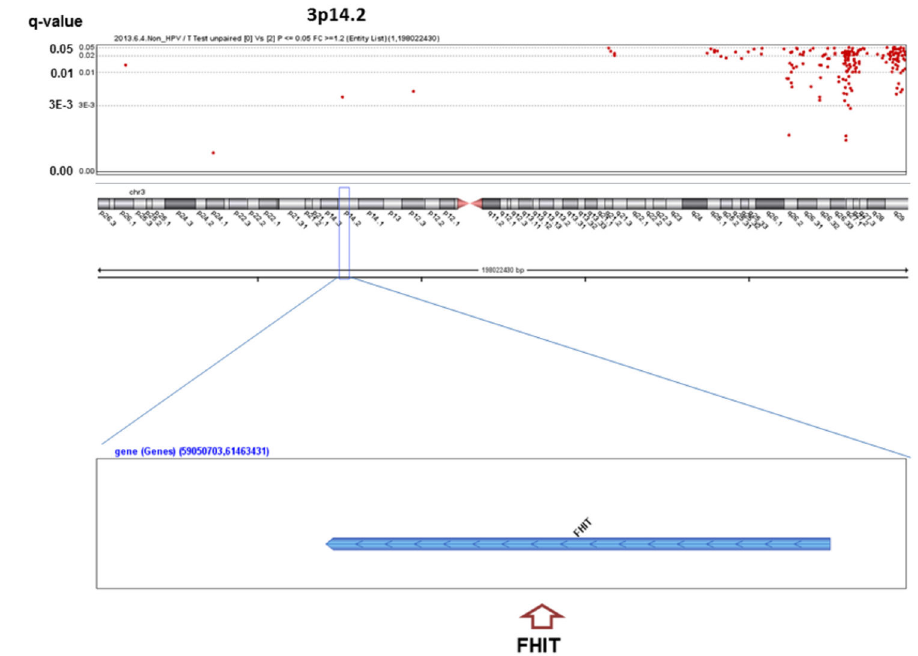
Figure 2. Significant SCNAs at 3p14.2 associated with heavy alcohol consumption.